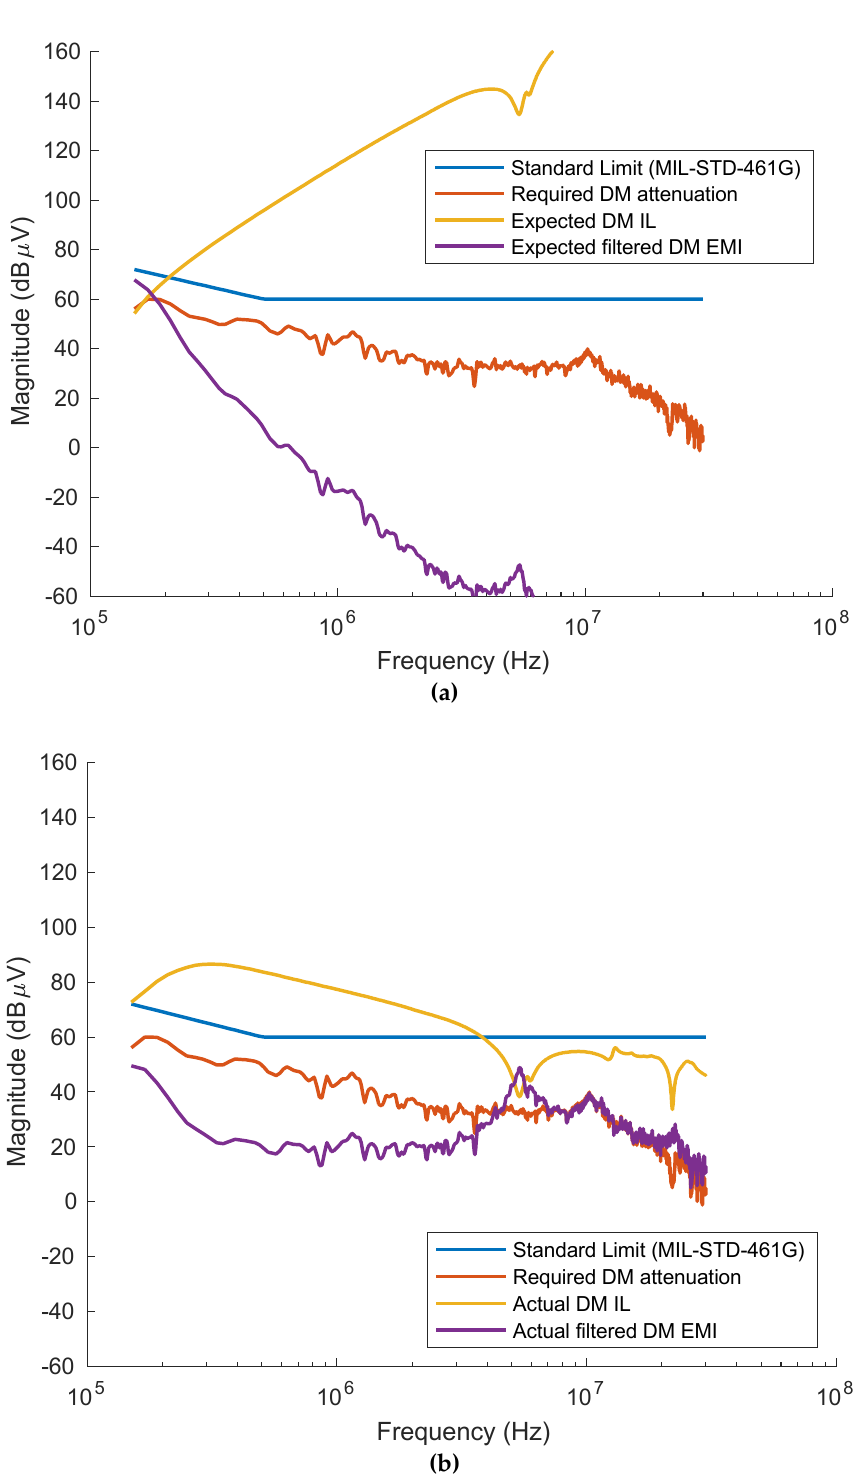
Figure 14. DM performance of the filter designed using the proposed approach: expected ( a ) and actual ( b ).